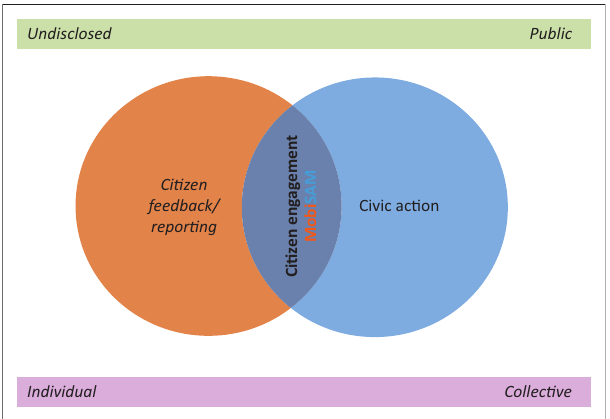
FIGURE 1: What citizen engagement means in